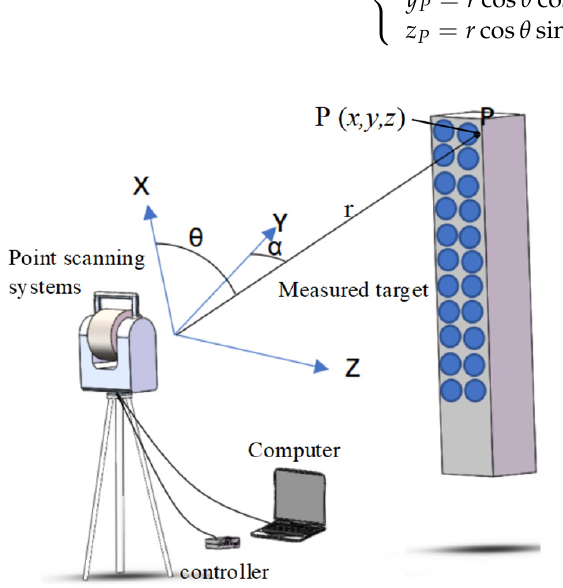
Figure 1. Schematic diagram of mechanism of single-point laser scanning measurement in spherical Figure 1. Schematicdiagramofmechanismofsingle-pointlaserscanningmeasurementinsphericalcoordinate. coordinate. The line scanning method projects a single laser line or multiple laser lines to the measured surface, as shown in Figure 2. Numerous points of measurement along the line can be collected at one time. The number of points along the line scanning is related to the hardware of the scanning system [18]. The line scanning systems are commonly found in the LJ-G5000 series laser 2D/3D high-precision measurement systems produced by Keyence, Osaka, Japan.